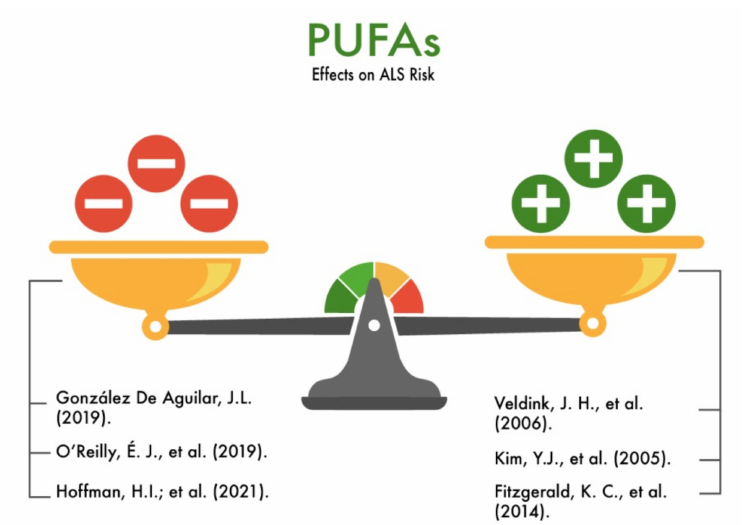
Figure 12. The effect of polyunsaturated fatty acids on the risk of developing amyotrophic lateral sclerosis